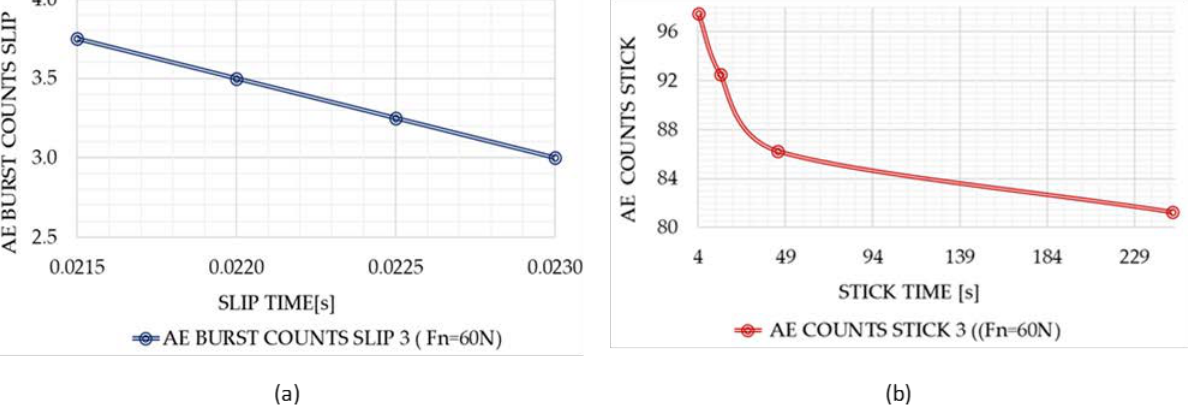
Figure 8. Distribution of the AE burst counts along the slip time ( a ), and AE counts along the stick time ( b ).